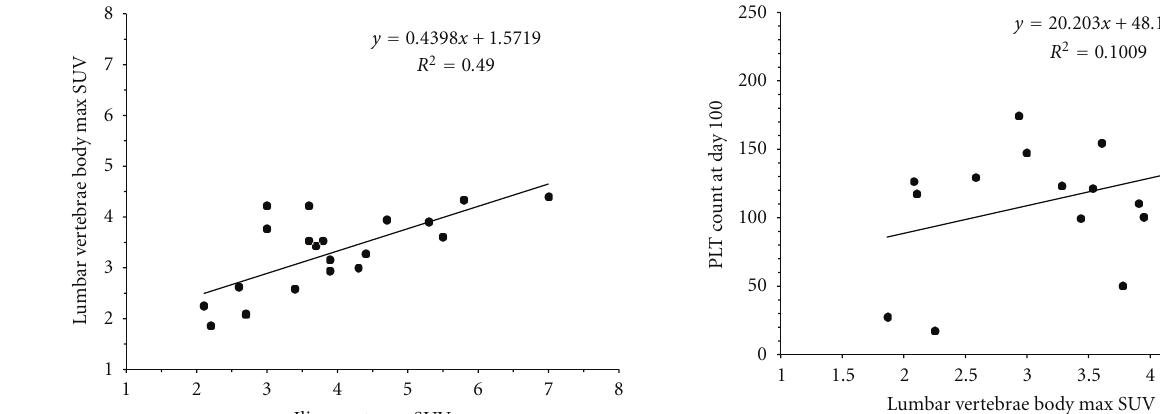
Figure 3: Correlation existing between maximal standardized FDG uptake values (SUV) within iliac crests and lumbar vertebrae. The tight correlation between injected sites and lumbar vertebrae metabolism confirmed a close parallelism between the degree of BM glucose consumption in these two di ff erent districts.